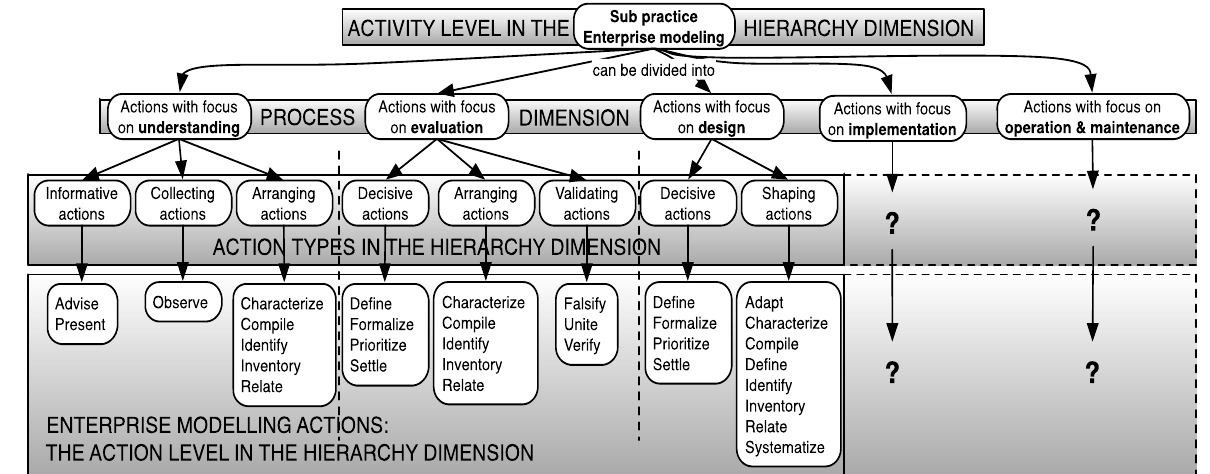
Figure 11. Possible extension of the EM